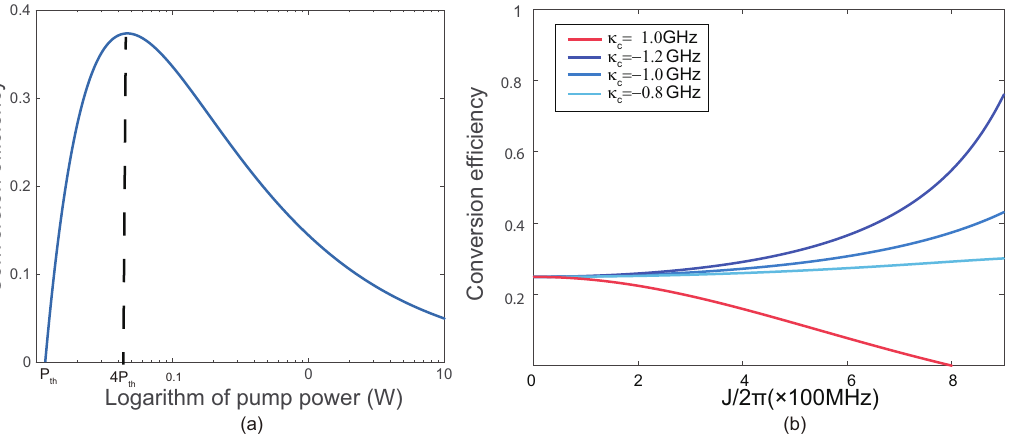
Figure 3. ( a ) Energy conversion efficiency η as a function of pump power P p . The parameter J = 800 MHz. The dotted line is the maximum energy conversion efficiency η = 37%, which is located at P p = 4 P th . ( b ) Energy conversion efficiency η as a function of the coupling strength J . The pump power is at P p = 4 P th . The other parameters in ( a , b ) are the same as in Figure